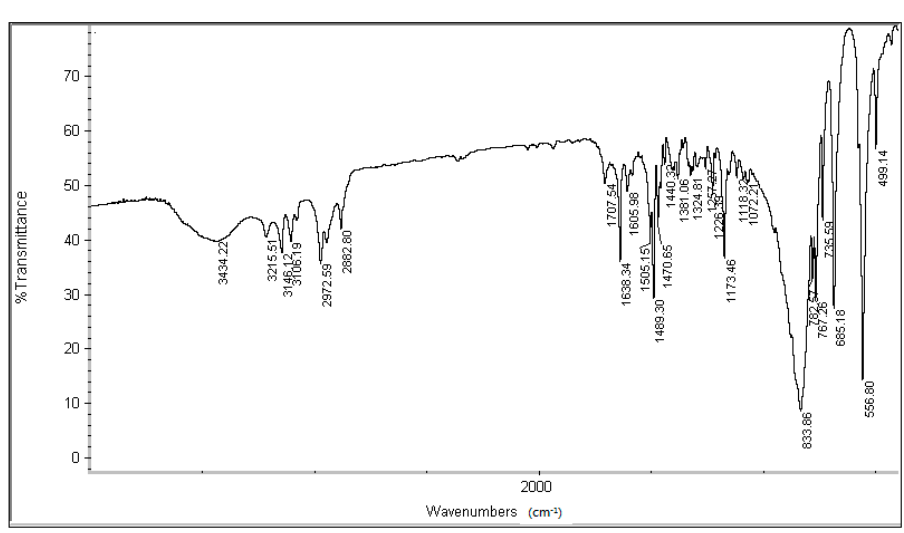
Figure 5. IR of [BPy]PF